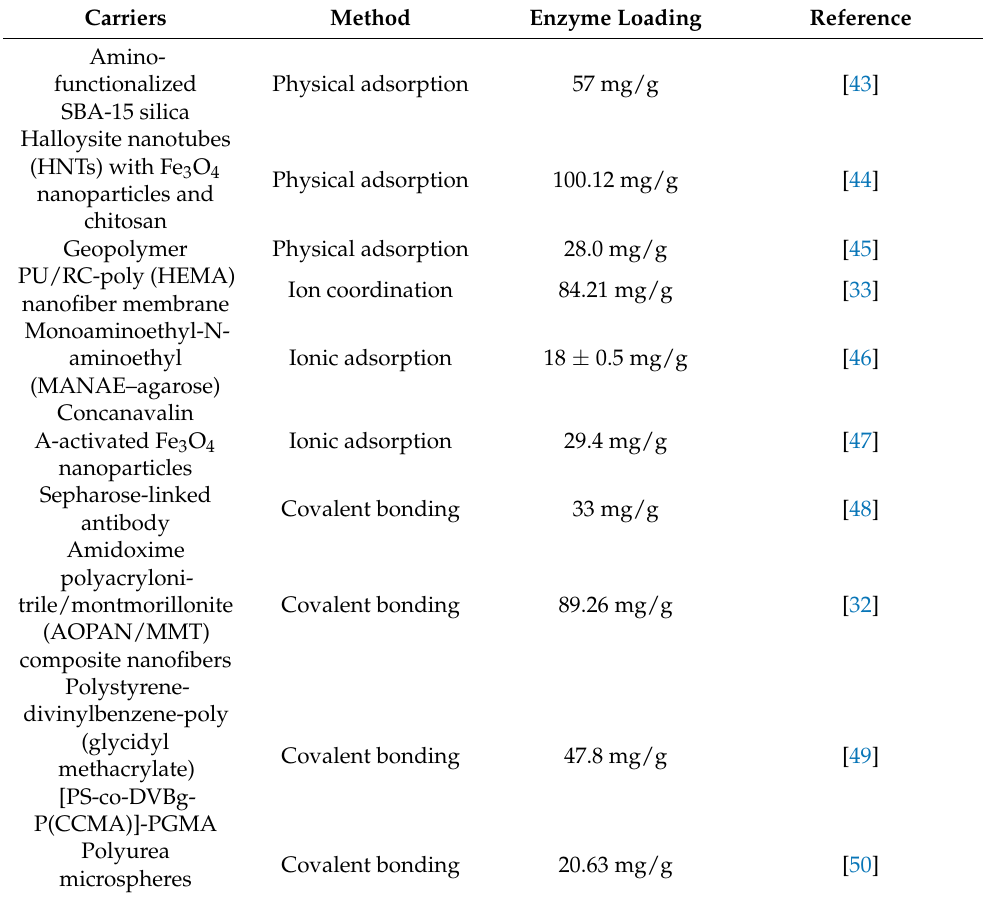
Table 1. Performance of the immobilized laccase using various immobilization methods and carriers.